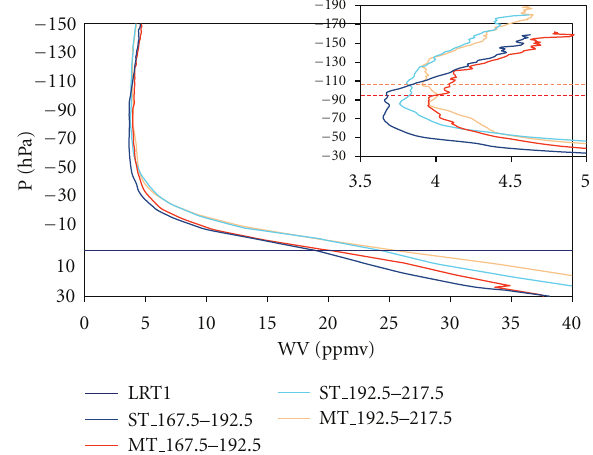
Figure 1: Vertical profiles of WV content (in parts per million by volume) relative to the pressure of the first tropopause (LRT1) shown for single (ST) and multiple tropopauses (MT) and over a range of pressures of occurrence (in hPa) of both phenomena. The part of the figure between 3.5 and 5ppmv is enlarged in the upper right-hand corner in order to obtain a better insight of the changes in the vertical profile. The horizontal lines correspond to the second lapse-rate tropopause (colour denotes the pressure range where it